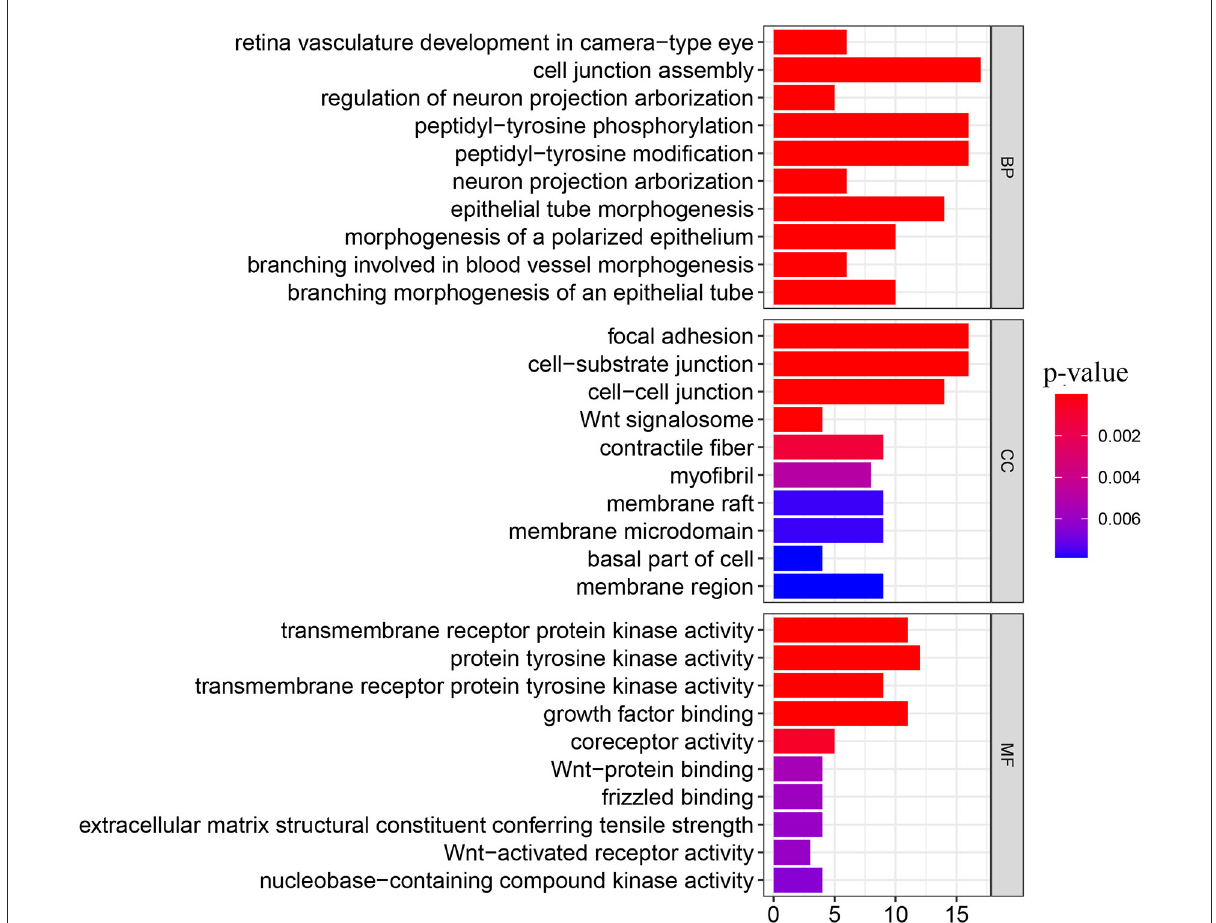
FIGURE9 GO enrichment analysis. The y-axis shows top 10 significantly enriched BP, CC, MF categories, and the x-axis displays the enrichment scores of these terms ( P -value <